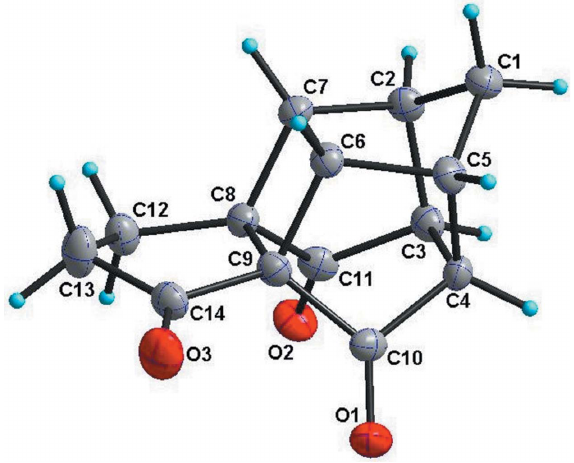
Figure 1 The molecular structure of the title compound (II), with displacement ellipsoids drawn at the 50% probability level.